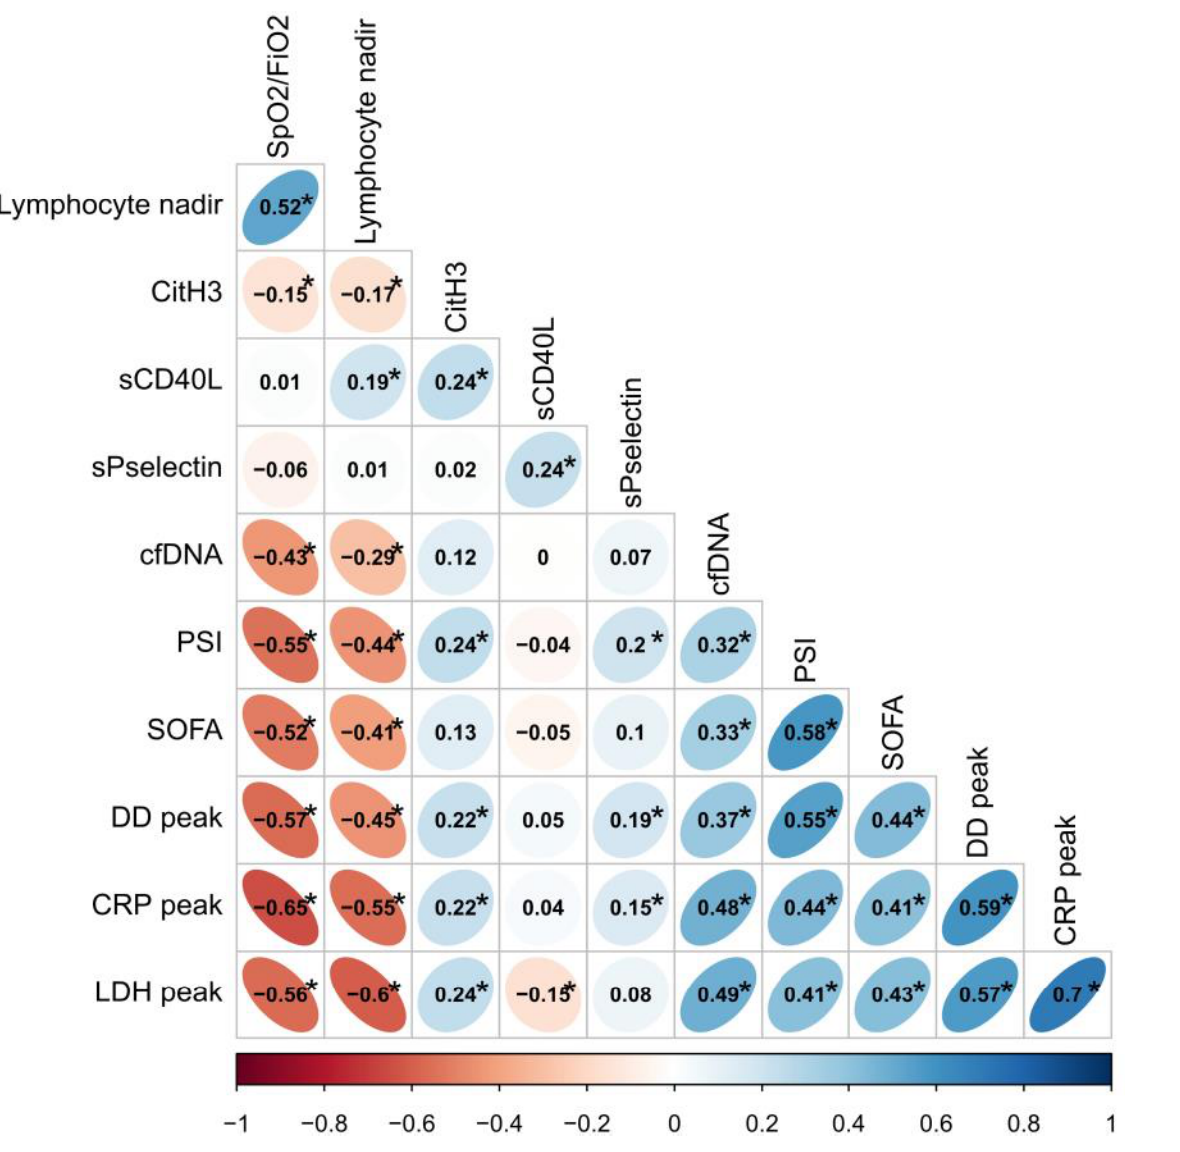
Figure 2. Correlation plot. Neutrophil extracellular traps and platelet activation markers are related to initial severity and prognostic analytical parameters in patients with COVID-19. CRP: C-reactive protein; DD: D-dimer; PSI: pneumonia severity index; SpO 2 /FiO 2 : peripheral blood oxygen satura- tion/fraction of inspired oxygen; SOFA: sequential organ failure assessment score. We used peak levels of analytical parameters and the lymphocyte count nadir during admission. Correlations were automatically grouped according to similarity. * p < 0.05.